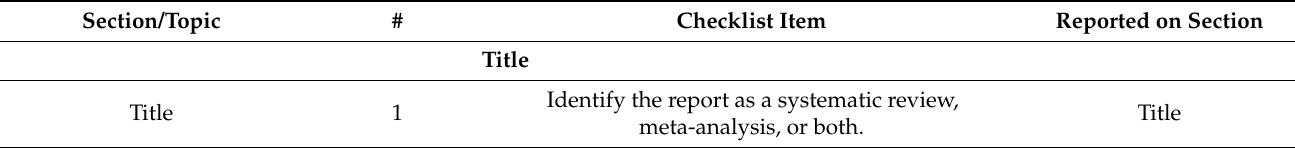
Table A1. PRISMA checklist, retrieved from PRISMA website. Some items were not included (X) since this is a systematic review and not a